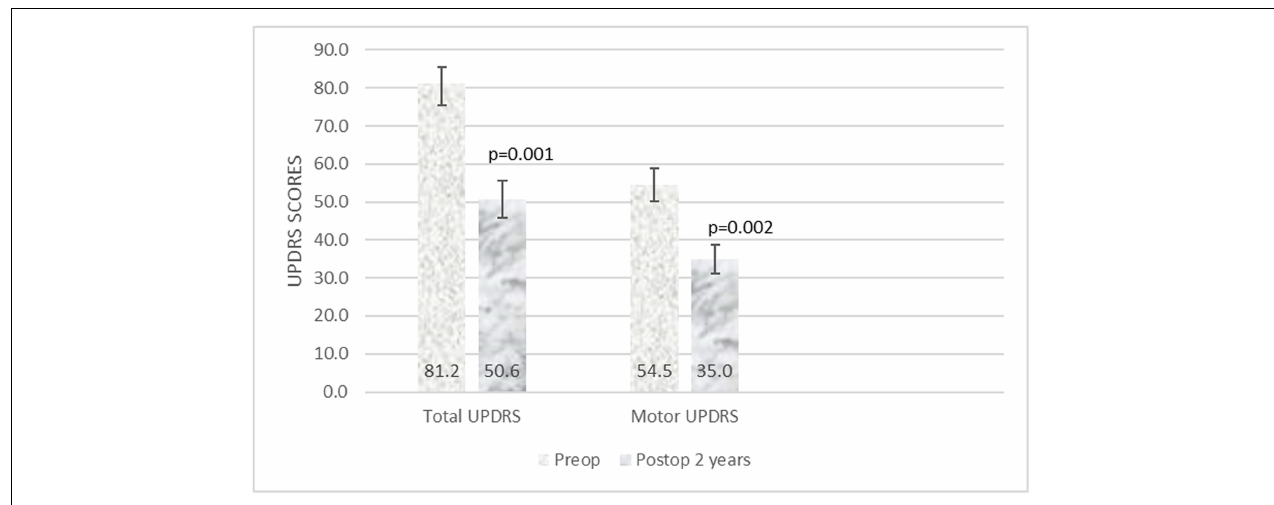
FIGURE 3 | Total and motor UPDRS at two years follow-up after subthalamotomy.